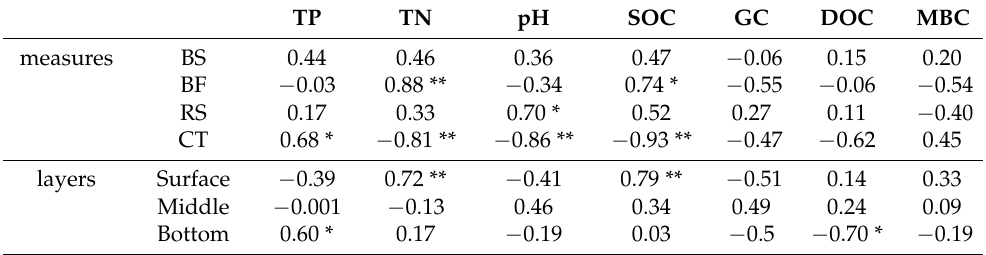
Table 2. Pearson correlations between bacterial 16S rRNA gene copy number and soil properties under different soil and water conservation measures. Asterisks indicates significant correlation (** p < 0.01, * p < 0.05).